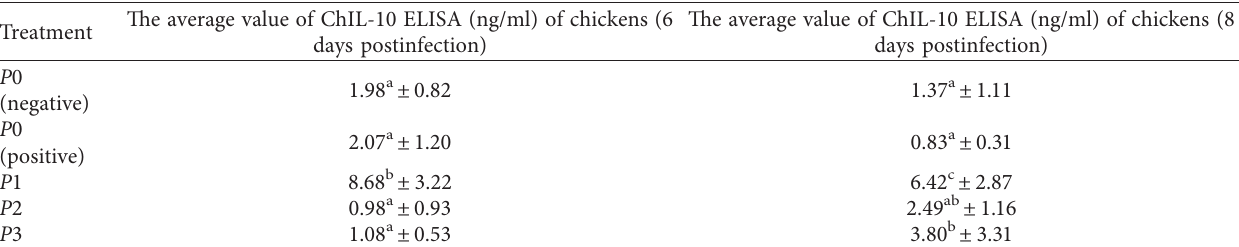
Table 2: The average value of ChIL-10 ELISA (ng/ml) in the blood serum of chickens (6 and 8 days postinfection) infected with E . tenella . The average value of ChIL-10 ELISA (ng/ml) of chickens Treatment